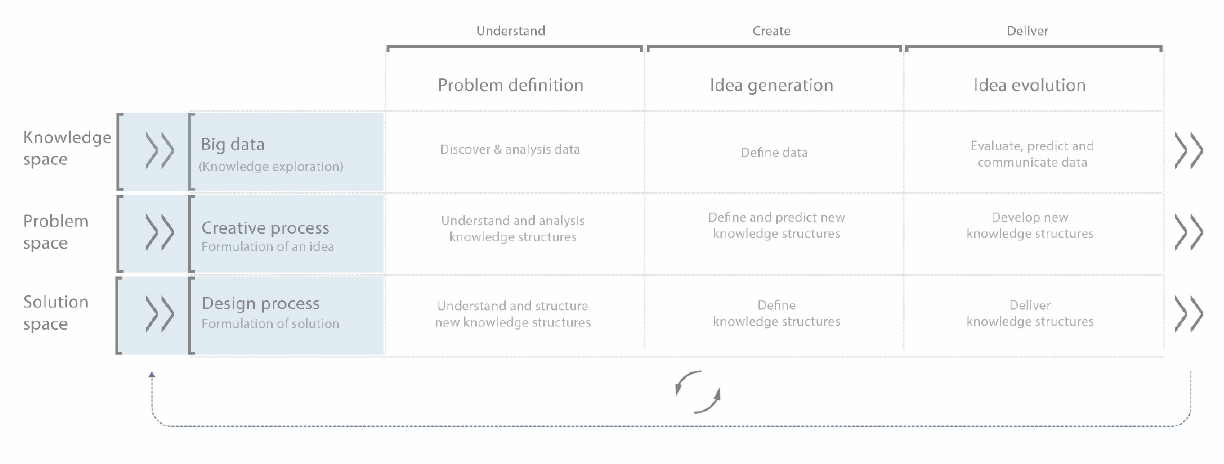
Fig. 4: Big Data and creative process and design process